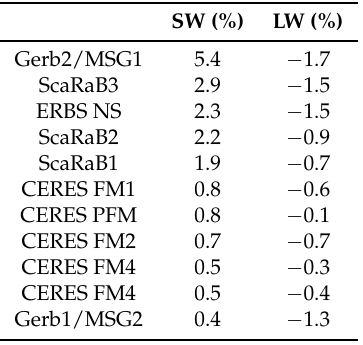
Table 6. Bias of instruments relative to the Earth Radiation Budget Satellite (ERBS) Scanner.